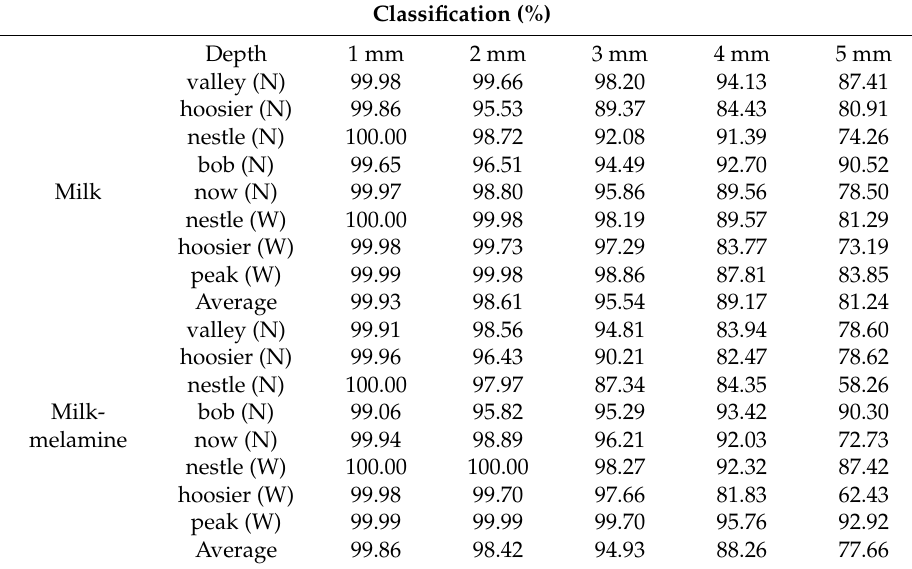
Table 1. Classification results of the validation set for milk and milk-melamine samples from a 1-mm–5-mm depth using PLS-DA coupled with the Standard Normal Variate (SNV) spectra preprocessing algorithm.